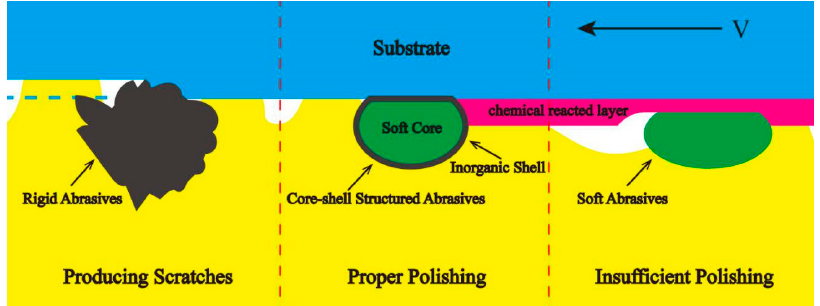
Figure 16. Probable material removal mechanism of the chemical mechanical polishing (CMP) process